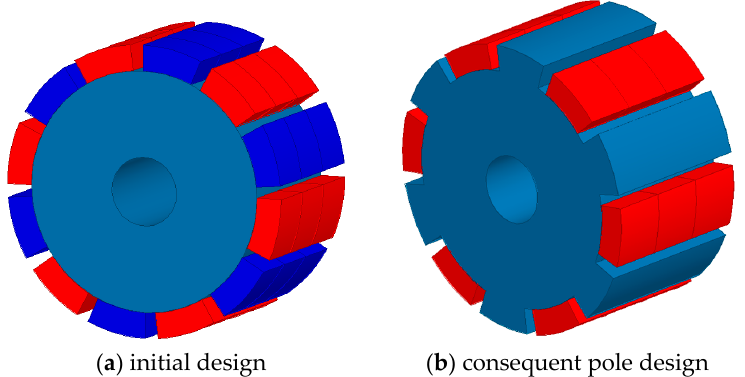
Figure 12. Different magnet designs for CPM.